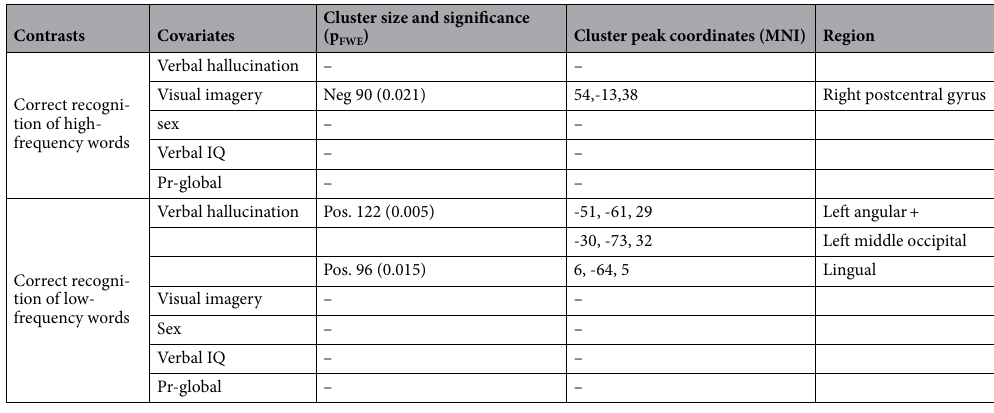
Table 1. Brain activation areas significantly associated with each covariate (verbal hallucination proneness, visual imagery, sex, verbal IQ, and Pr-global) during the correct recognition of high- and low-frequency words in the 37 participants. MNI MNI stereotactic coordinates, p FWE family-wise error corrected p